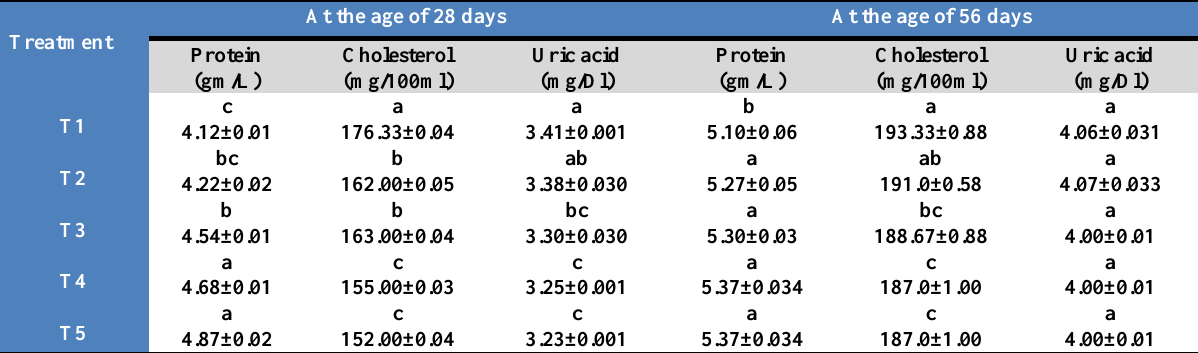
Table, 4: The effect of the addition residues of the tomato paste industry on some blood parameters of the broiler at the age of 28 days and 56